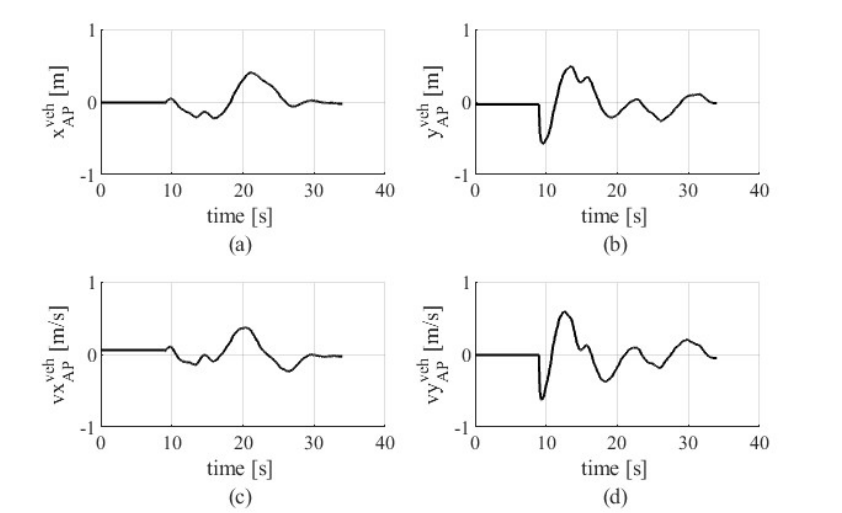
Figure 8. The apron state estimation results, including ( a , b ) the relative position and ( c , d ) the relative velocity of the apron in { B } .